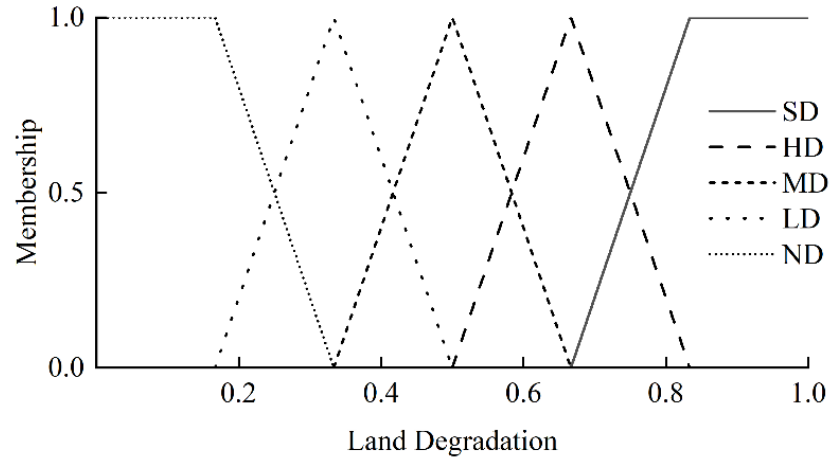
Figure 5. Membership of the different land degradation index degree.